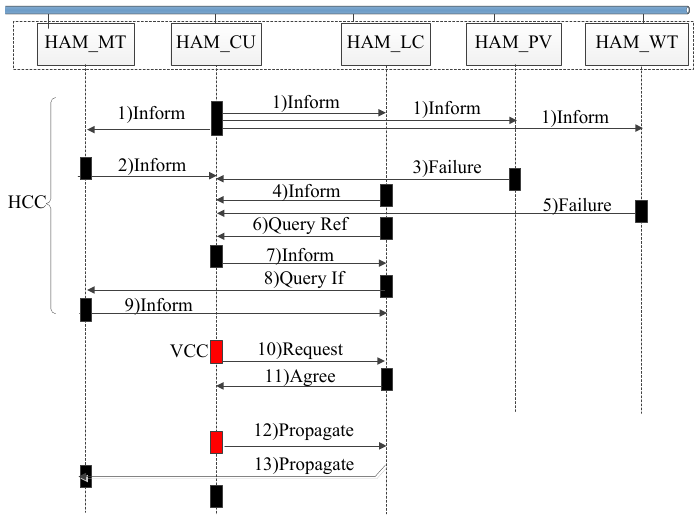
Figure 12. Processes of negotiations among HAMs in Scenario